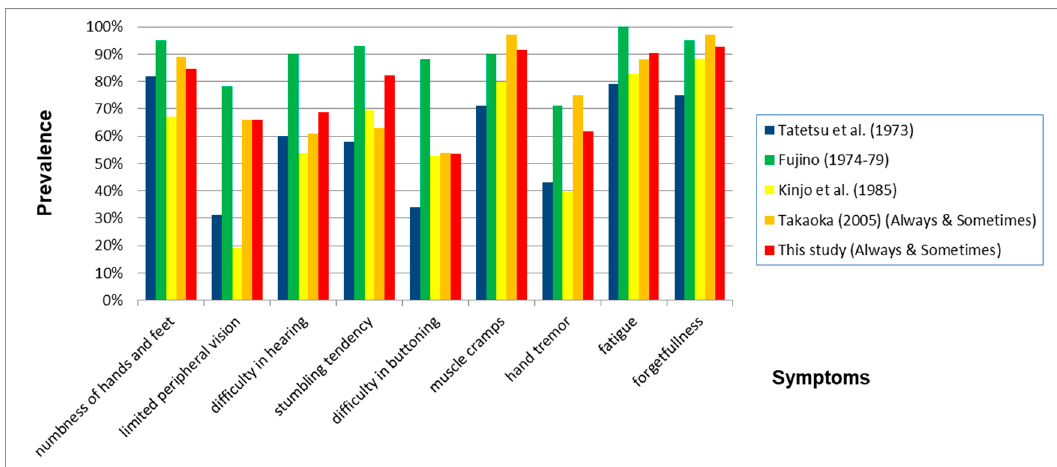
Figure 18. Prevalence of symptoms when comparing nine questions common to all five studies. The prevalence of all characteristic symptoms for Minamata disease was very. In this study, we used the prevalence of “sensory numbness in both hands” instead of “numbness of hands and feet”.